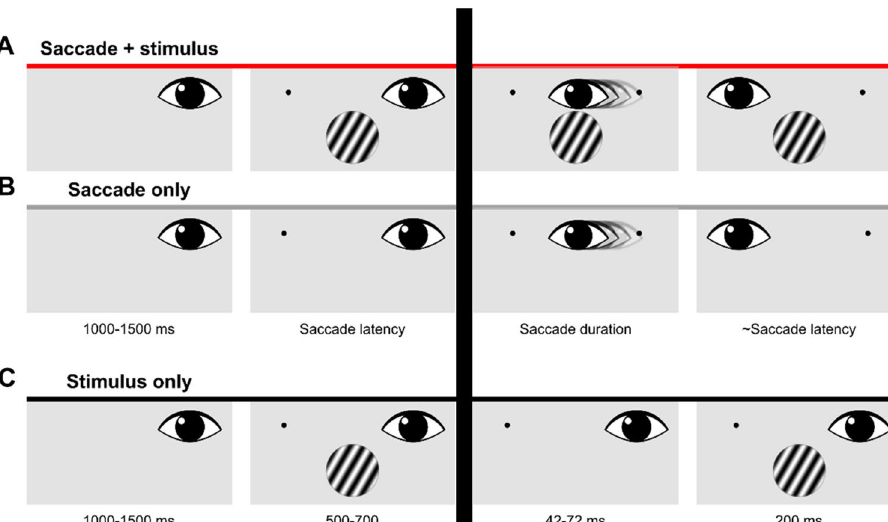
Figure 1. Illustration of the three conditions. Only data prior to the saccade (left of the dark vertical bar) was used for the analysis. ( A ) Timeline of events in the Saccade + stimulus condition. These trials were gaze contingent. Durations of each event are displayed at the bottom of panel B. On half of the trials, the stimulus would change its orientation during the saccade, from -30° to 30° or vice versa. Responses were given with button presses. ( B ) Timeline of events in the Saccade-only condition. In this condition participants only made a saccade; they did not perform the orientation-change detection task. ( C ) Timeline of events in the Stimulus-only condition. This condition was not gaze contingent, instead the first stimulus was briefly removed for a period that was sampled online from a distribution of saccade durations that were measured in the saccade conditions. Participants performed the same orientation-change detection